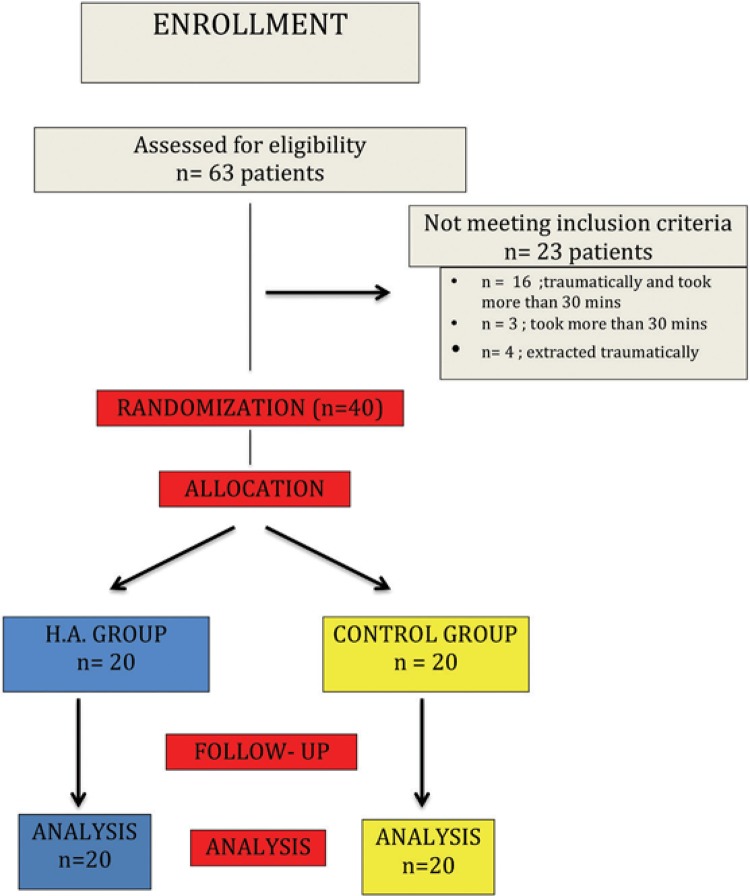
Study flowchart